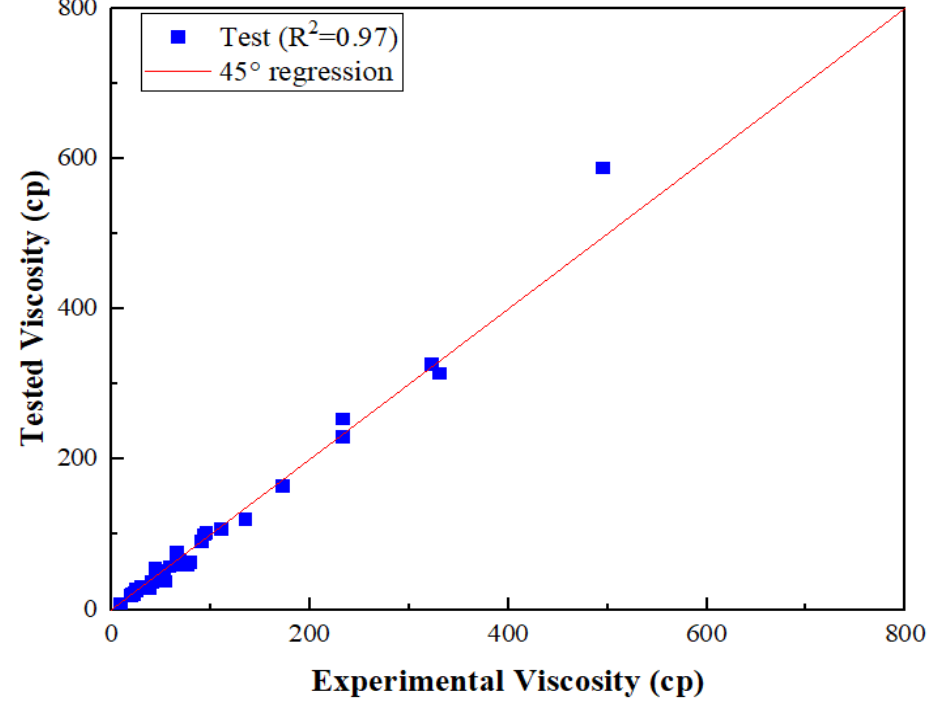
Figure 6. Regression plot of experimental versus trained viscosity.